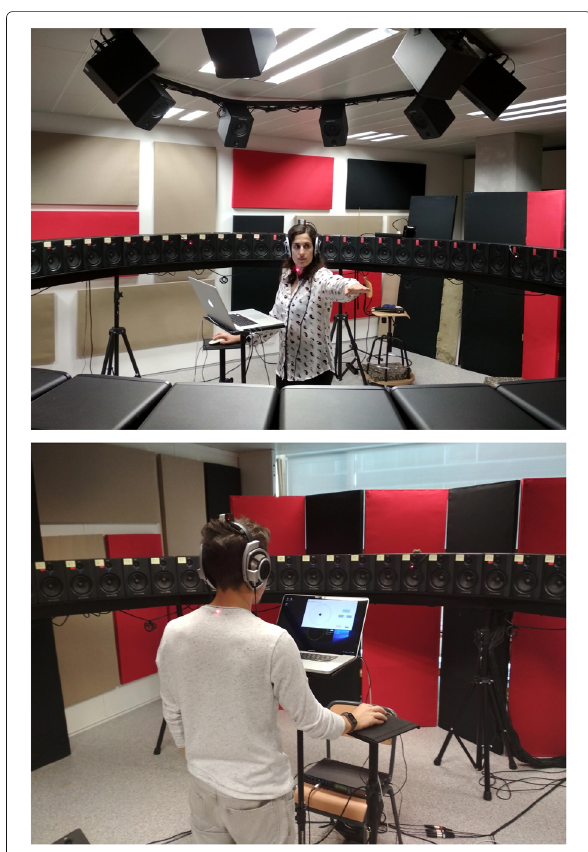
Fig. 5 Subjects performing the ITD variations perceptual